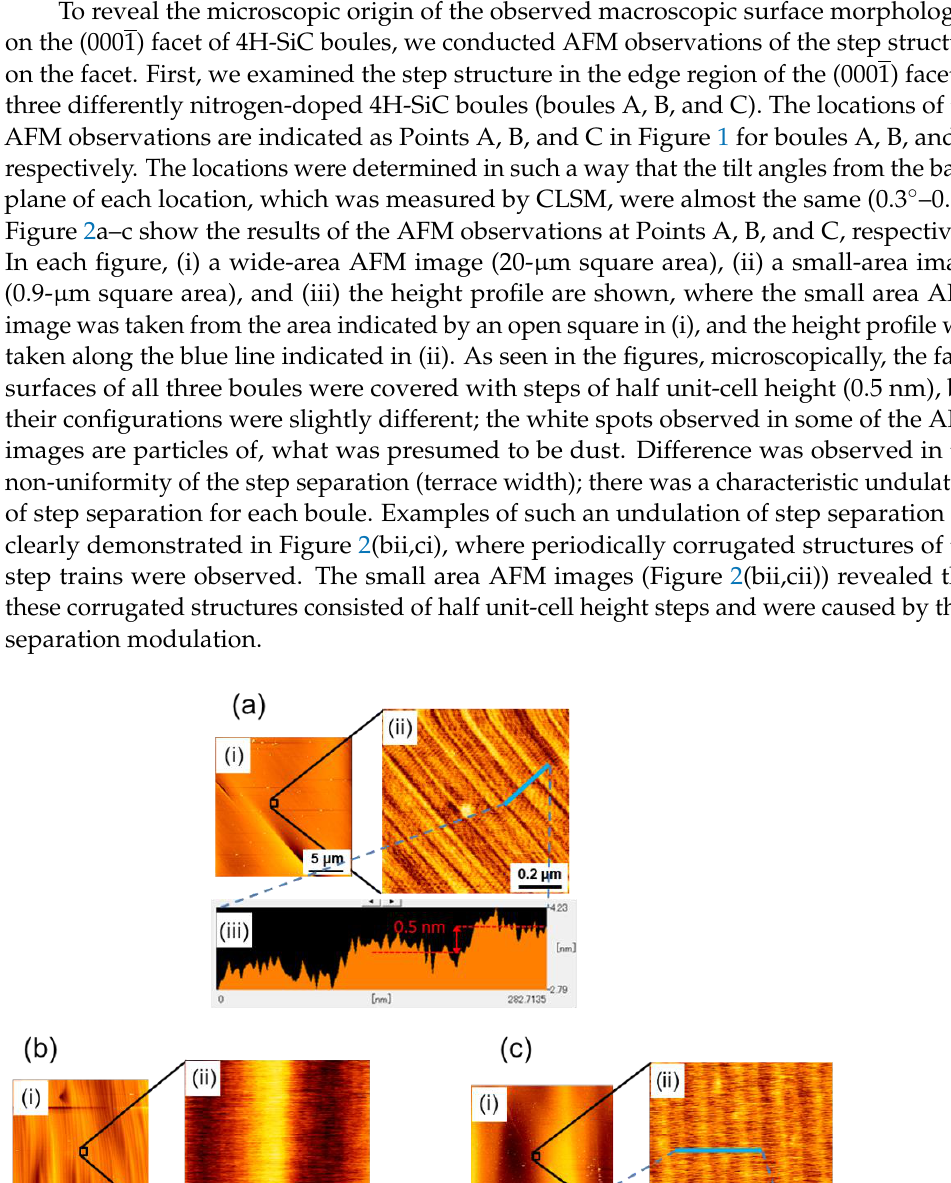
Figure 2. AFM images at ( a ) Point A, ( b ) Point B, and ( c ) Point C near the edge of the (0001 of boules A, B, and C, respectively. In each figure, ( i ) wide-area AFM image (20- µ m square area), ( ii ) small-area image (0.9- µ m square area), and ( iii ) height profile are shown, where the small-area AFM image was taken from the area indicated by an open square in ( i ), and the height profile was taken along the blue line indicated in ( ii ).